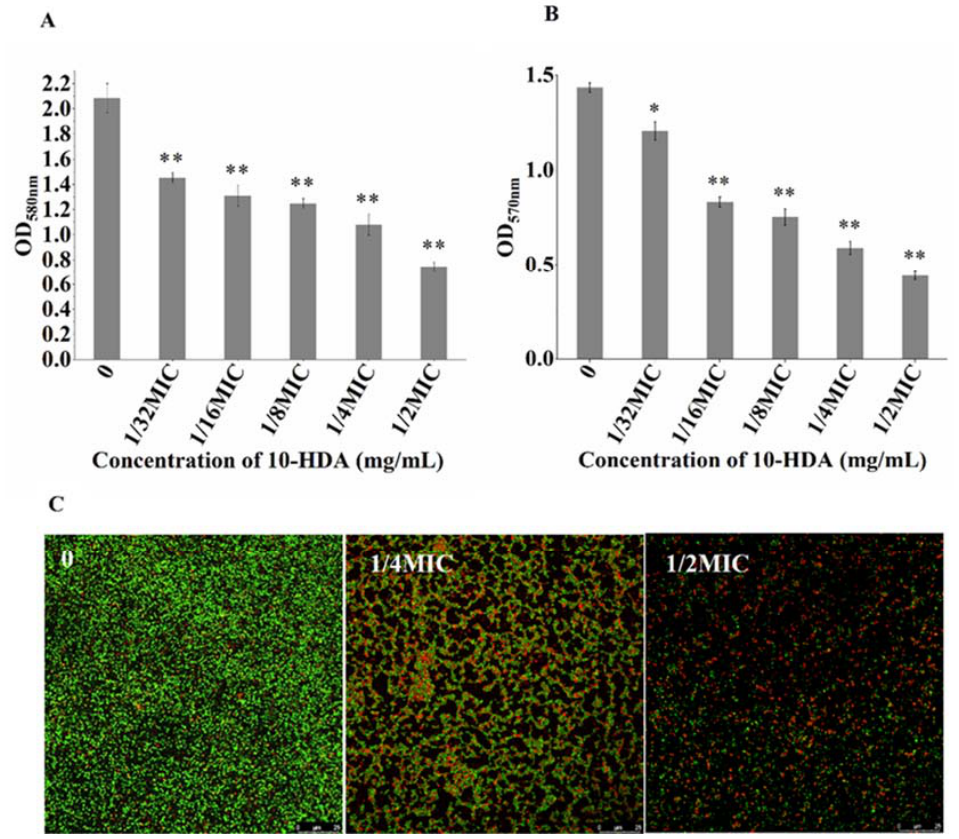
Figure 5. ( A ) Effect of 10-HDA on S. aureus mature biofilms, as analyzed by crystal violet staining method. ( B ) MTT assay on the effect of 10-HDA on the cell metabolic activity in S. aureus mature biofilms. * p < 0.05, ** p < 0.01. ( C ) CLSM images of S. aureus mature biofilms. Green fluorescence: live cells; red fluorescence: dead